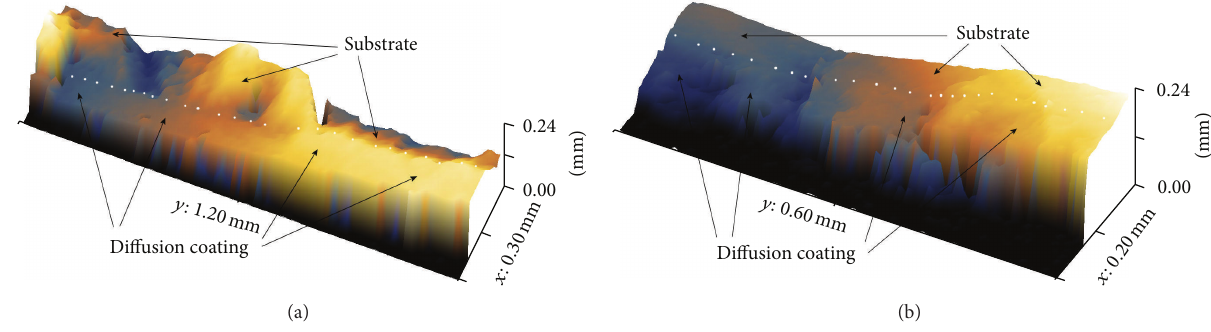
Figure 5: 3D view of initiation sites in specimens subjected to (a) bending ( 𝑍 = 0 , 𝑁 𝑓 = 6.3 × 10 3 cycles) and (b) torsion loading ( 𝑍 = 1 , = 7.0 × 10 2 cycles). 𝑁 𝑓